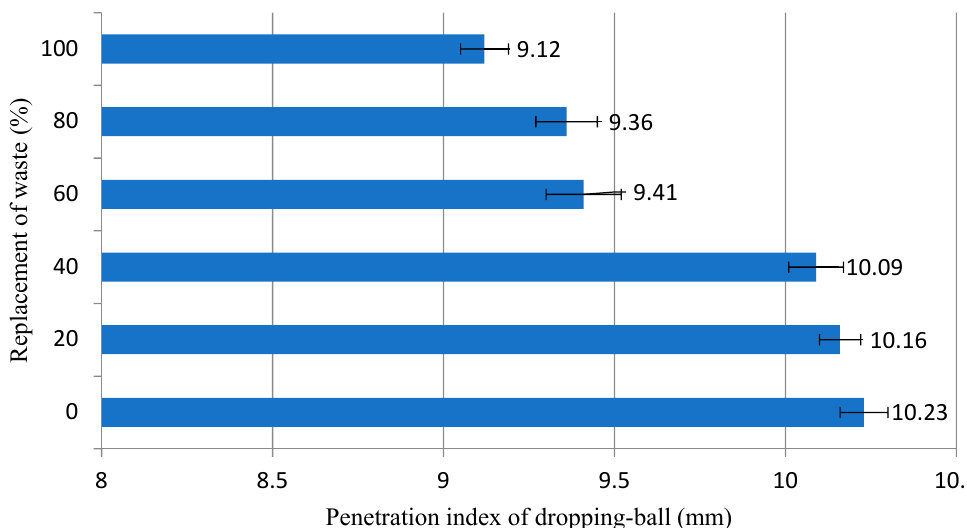
Figure 9. Penetration index results obtained by dropping-ball for mortars evaluated.